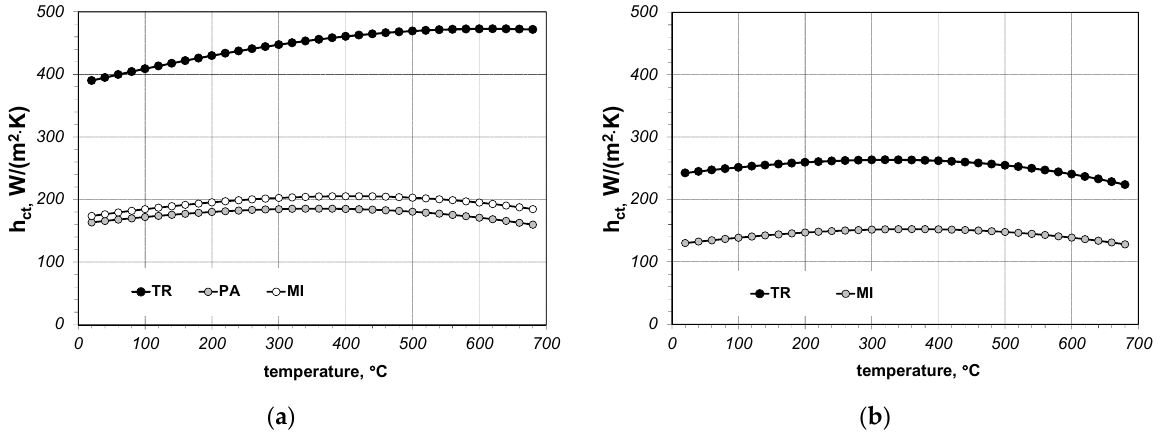
Figure 9. Calculated values of contact conductance: ( a ) results obtained for samples made of 5 × 20 mm bars; ( b ) results obtained for samples made of 10 × 40 mm bars.